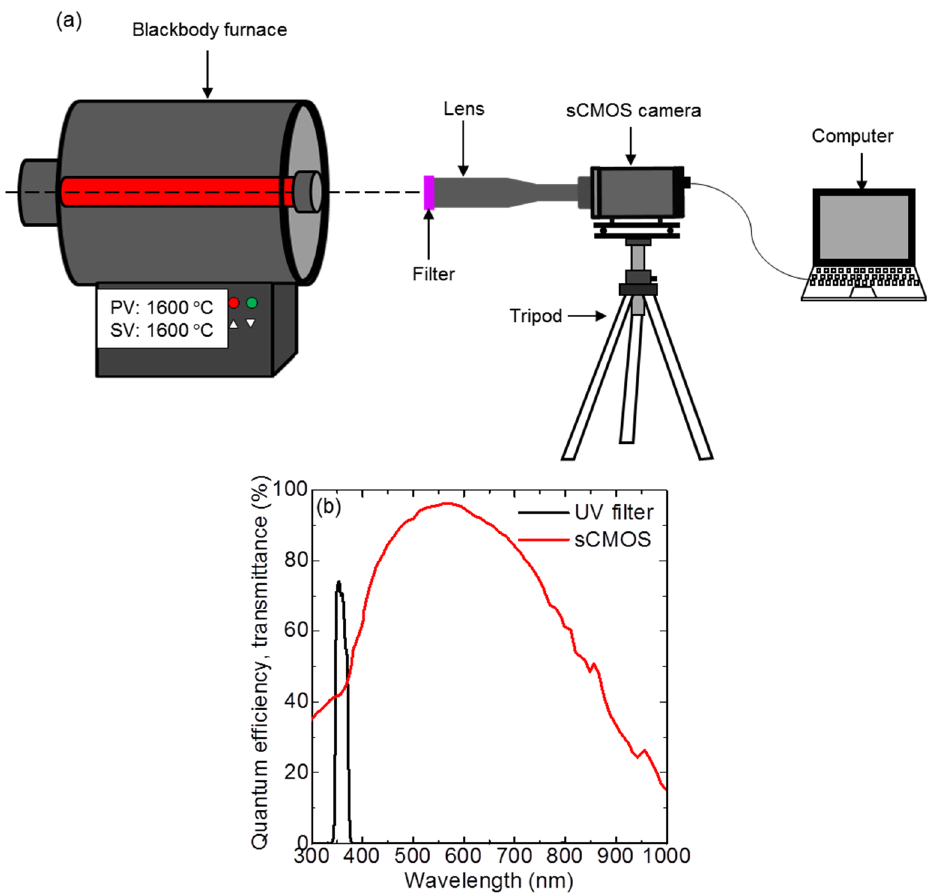
Figure 3. ( a ) Schematic illustration of calibration of the UV imaging system for temperature measurement via a blackbody furnace and ( b ) optical properties of camera and filter used in the UV imaging system.